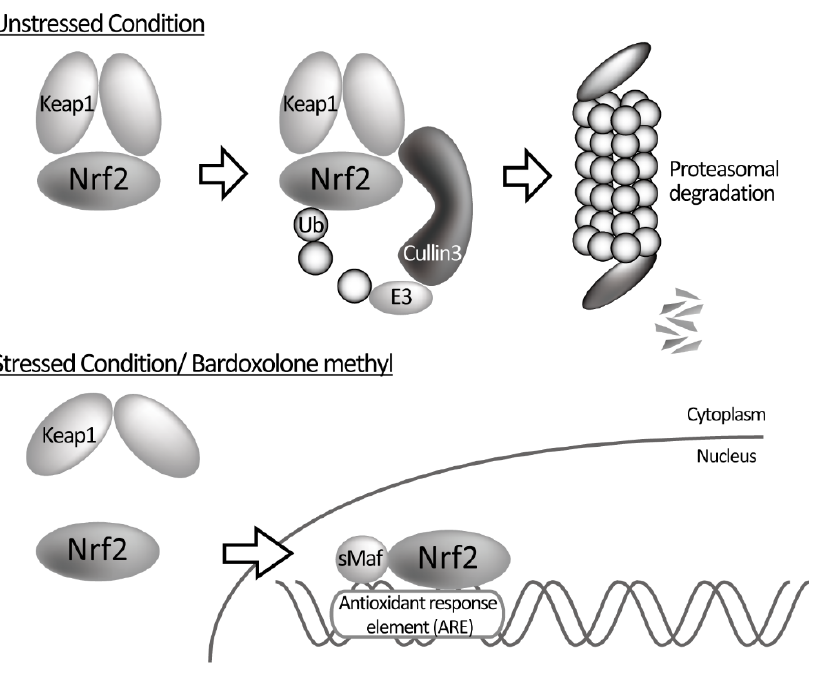
Figure 2. Regulation of NRF2. Under normal conditions, NRF2 is captured by KEAP1, ubiquitinated by Cullin3-type E3 ubiquitin ligase, and degraded by the proteasome. Under oxidative stress or bardoxolone methyl administration, NRF2 evades from degradation due to the conformational change of KEAP1 and is transferred into the nucleus. NRF2 binds to the antioxidant response element (ARE) along with the small musculoskeletal fibrosarcoma oncogene homologue (sMaf), resulting in the expression of downstream genes.